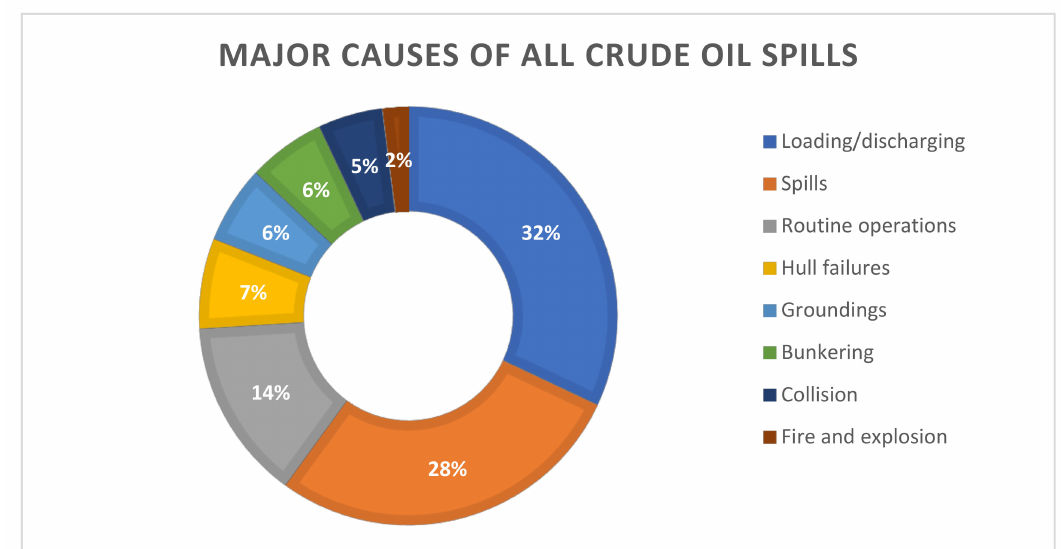
Figure 2. Major causes of all crude oil spills